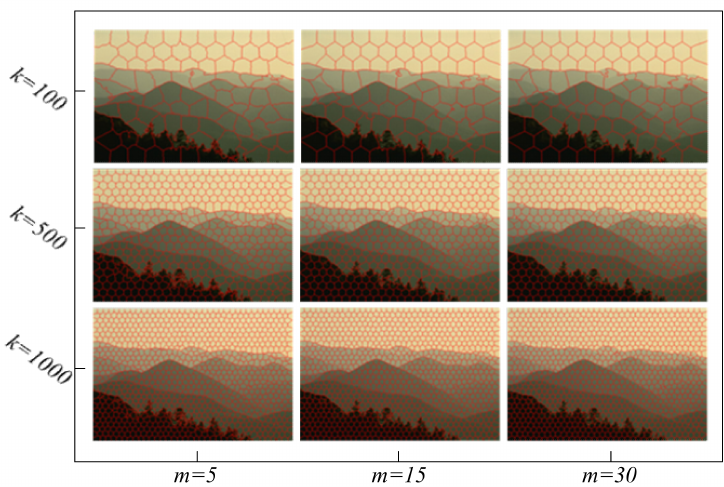
Figure 2. The segmentation results of BSLIC algorithm under different input parameters. The image resolution is 481 × 321. From the first row to the third row, the parameter superpixels number k is 100, 500, and 1000. From the first column to the third column, the parameter weight factor m is 5, 15, and